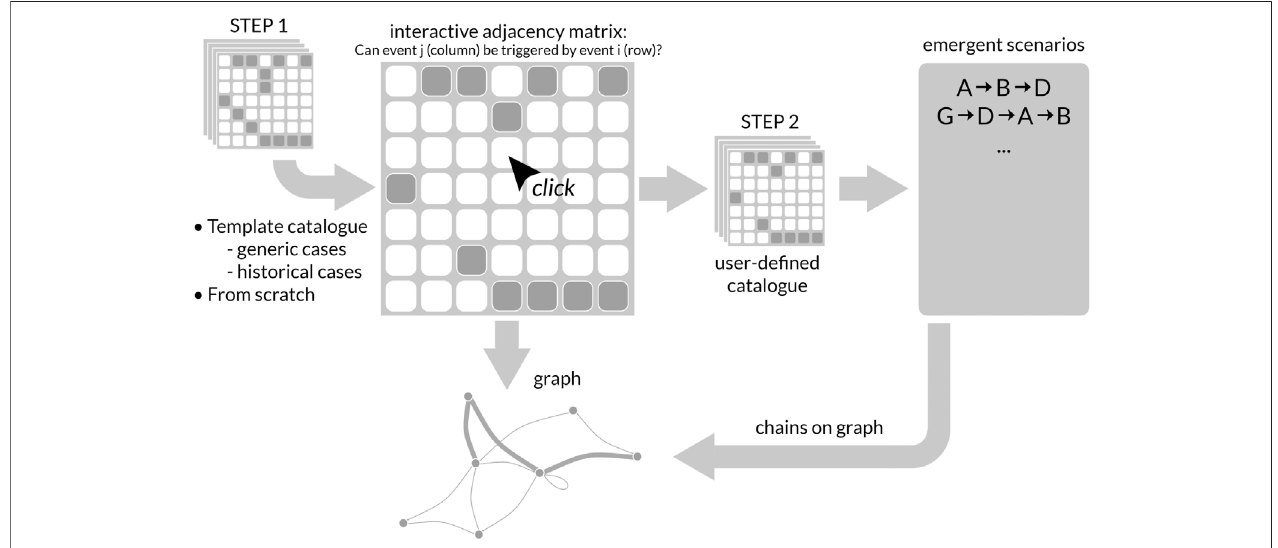
FIGURE 1 | Sketch of the online interactive platform for the pre-assessment phase of super-catastrophes. Emergent scenarios of domino effects are generated from the user-de fi ned adjacency matrices and can be visualized on the resulting graph of interactions. See Online Platform Prototyping for details.